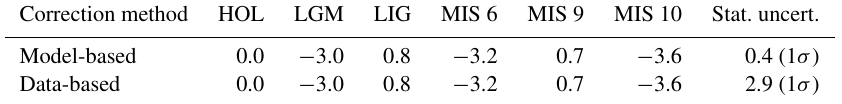
Table 2. Absolute MOT anomaly based on Kr / N 2 in degrees Celsius ( ◦ C) relative to the Holocene mean using both of our correction approaches. The Holocene value is the average of 10 EDC samples from 0–10.0kyrBP, the LGM value is the average of nine samples between 17.8 and 26kyrBP, LIG is the average of four samples between 120 and 129.9kyrBP, and MIS 6 includes four samples from 135–160kyrBP. MIS 9 and MIS 10 each comprise four samples.